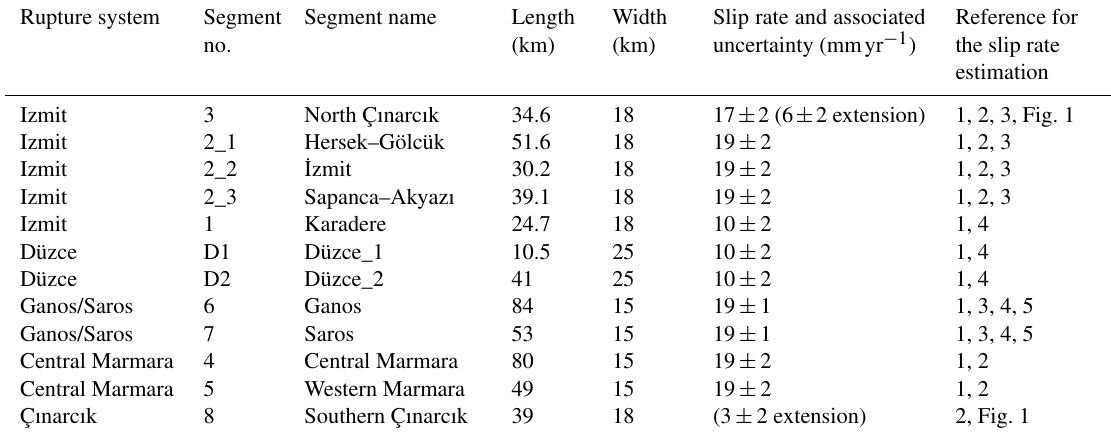
Table 1. The fault segments and rupture systems included in the SSC model. References given in the last column are (1) Flerit et al. (2004), (2) Murru et al. (2016), (3) Ergintav et al. (2014), (4) Ayhan et al. (2001), (5) Hergert et al. (2011). Weights associated with the mean, upper bound and lower bound are 0.5, 0.25, and 0.25,